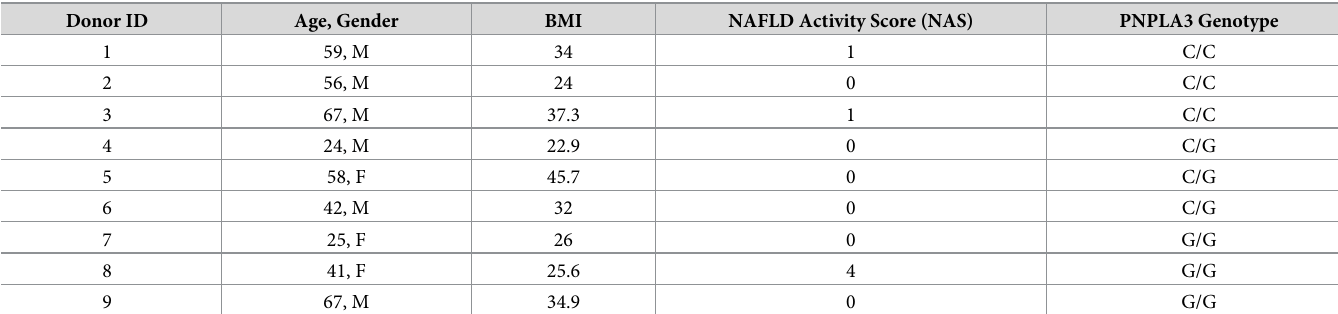
Table 1. Human hepatic stellate cell donor